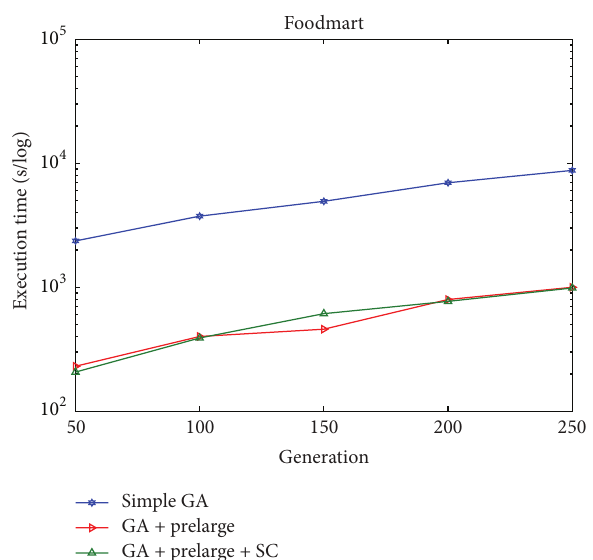
Figure 11: Execution time of the original GA-based algorithm and the GA-based algorithm involving prelarge concept (with and without sliding count) in foodmart